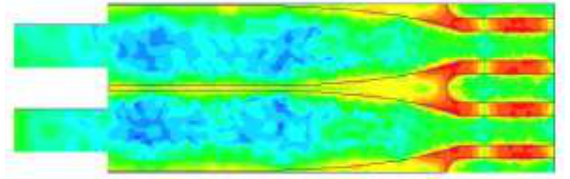
Figure 5: The symmetry of currents inside the quadruple FLuS, due the use of P-QWT.